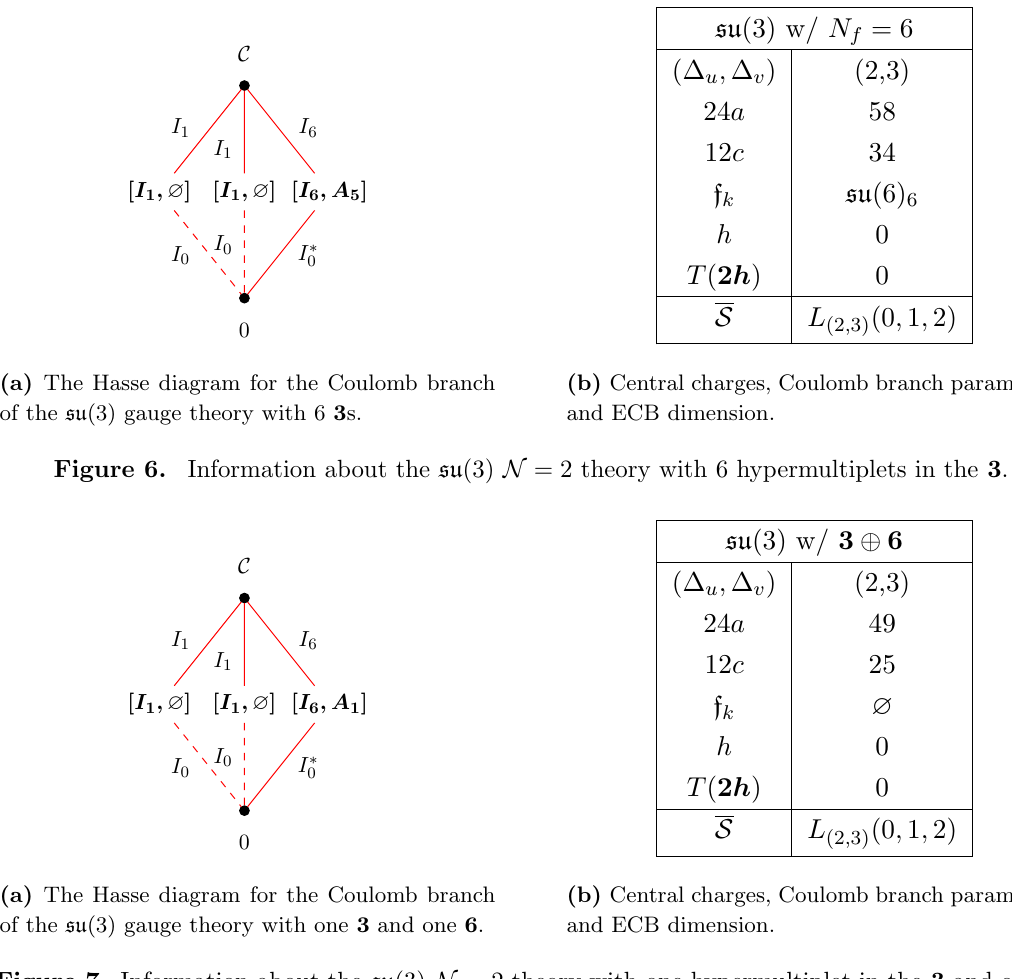
Figure 7. Information about the su (3) N = 2 theory with one hypermultiplet in the 3 and one in the 6